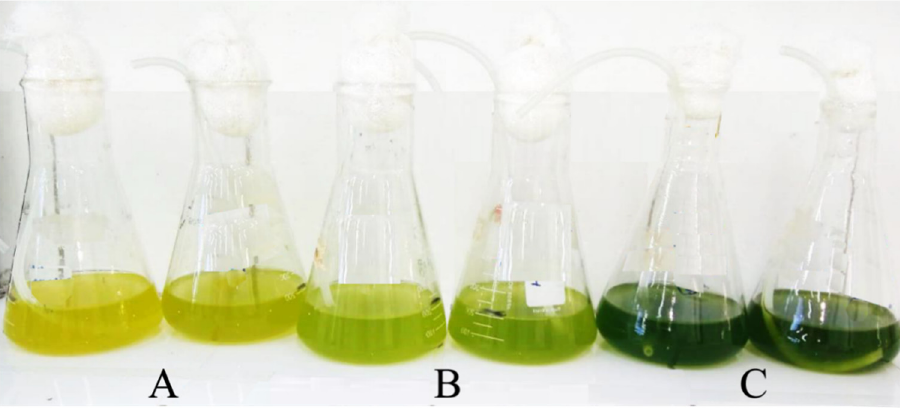
Figure 2. Color of D. tertiolecta (UTEX 999) cultivations in different culture media: F/2 medium ( A ), Bold’s Basal medium ( B ), Alternative medium ( C ).